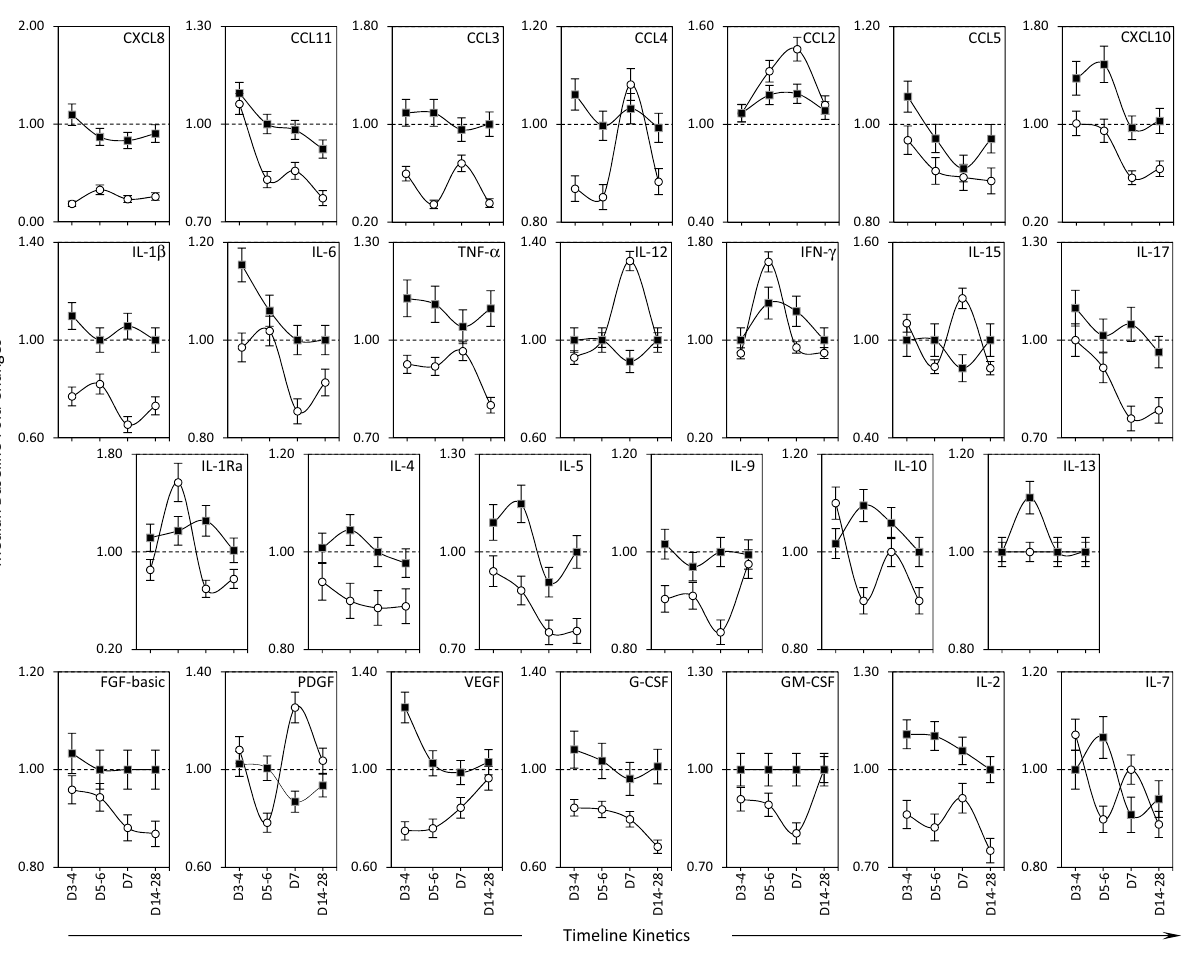
Figure 1. Timeline Kinetics of Serum Biomarkers in Patients with Autoimmune Disease Following Planned Primary 17DD-YF Vaccination. Panoramic timeline kinetics of serum chemokines (CXCL8, CCL11, CCL3, CCL4, CCL2, CCL5, CXCL10), pro-inflammatory cytokines (IL-1β, IL-6, TNF-α, IL-12, IFN-γ, IL-15, IL-17), regulatory cytokines (IL-1Ra, IL-4, IL-5, IL-9, IL-10, IL-13), and growth factors (FGF-basic, PDGF, VEGF, G-CSF, GM-CSF, IL-2 and IL-7) in serum samples from Autoimmune Disease patients (AID, black filled square, n = 140) and Healthy Controls (HC, white filled circle, n = 21). Measurements were carried out using the Luminex platform, according to manufacturer’s instructions as provided in Material and Methods. The results are expressed as median baseline fold changes ± variation at each time point along the kinetic follow-up (D3–4, D5–6, D7 and D14–28) according to the paired sample collected at D0. Data analysis was performed considering the baseline fold value = 1.0 as the reference for decrease (< 1.0) or increase (> 1.0) in biomarker levels along the kinetic